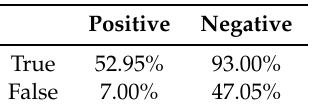
Table 2. Knife detection: results for the homogeneous texture descriptor.